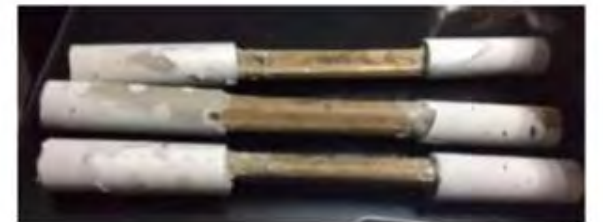
Figure 17. The tension specimens before testing (Author’s own, n.d.)